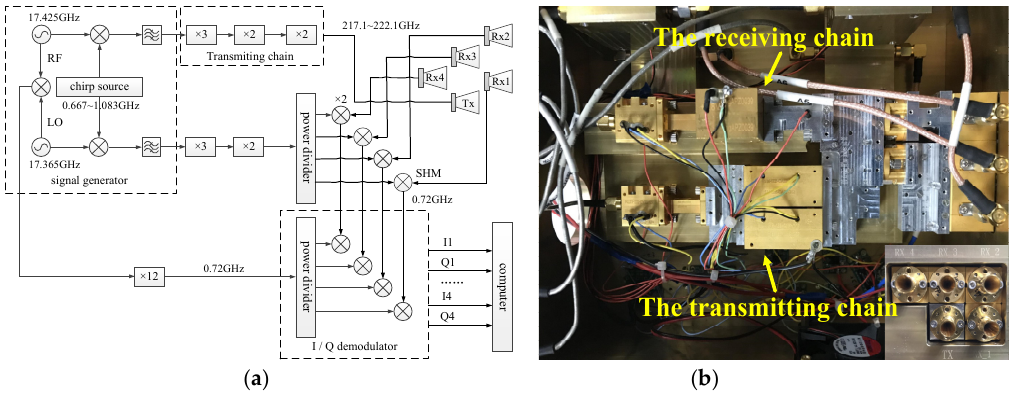
Figure 10. The terahertz radar system. ( a ) Schematic diagram. ( b ) Photograph of the front-end setup.